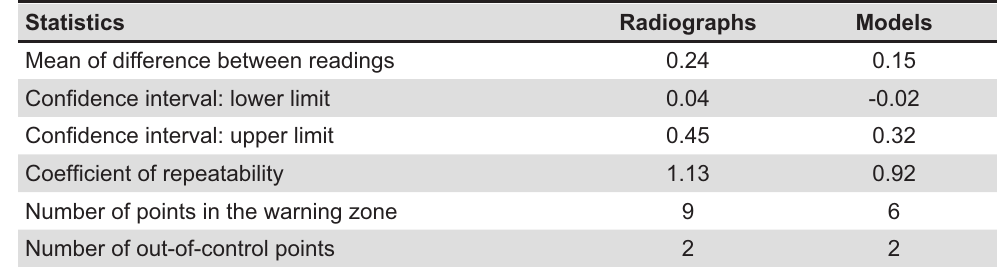
Figure 3- Control chart for the mean of differences between radiographs readings Table 2- Error analysis for upper-arch length projected onto the midsagittal plane in millimeters measured from models and cephalometric radiographs